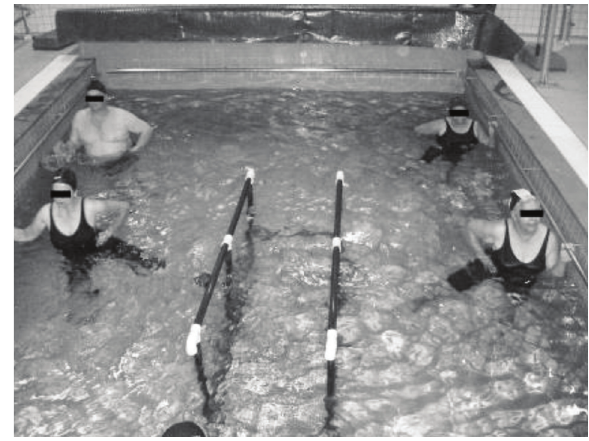
Figura 4 - Demonstração de caminhada multidirecional na FA Fonte: Dados da pesquisa.